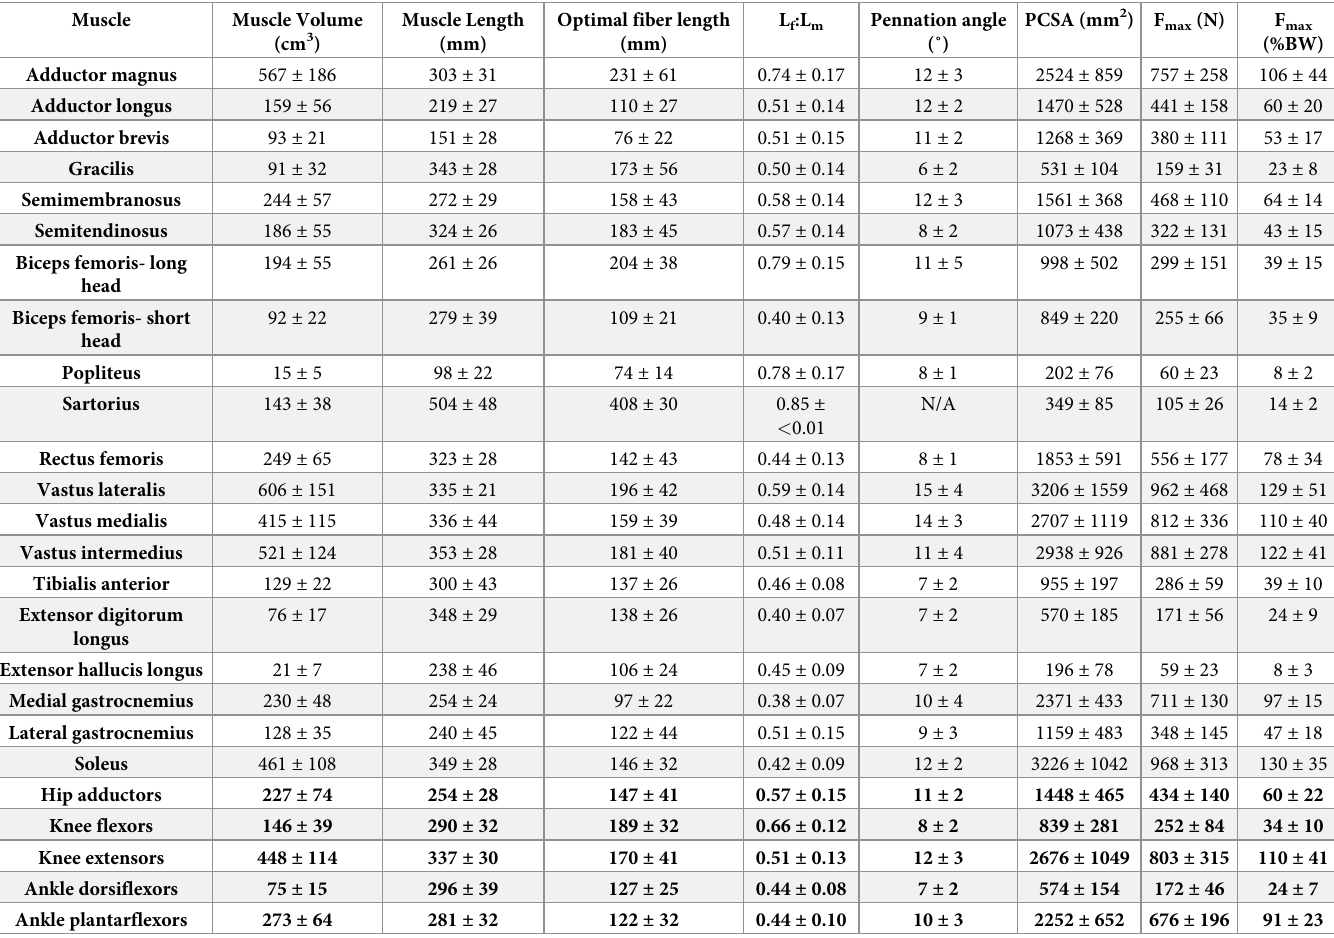
Table 3. Mean ( ± standard deviations) architecture properties of 20 lower limb muscles from 10 individuals (5 males, 5 females; Age- 27.3 ± 3.95 years. Body mass- 76 ± 12.5 kg), plus functional group means. L F :L m - Muscle fiber length muscle length ratio. PCSA- Physiological cross-sectional area. F max - estimated maximum isometric force. Sarcomere lengths used to estimate optimal fiber lengths were sourced from Ward et al.,